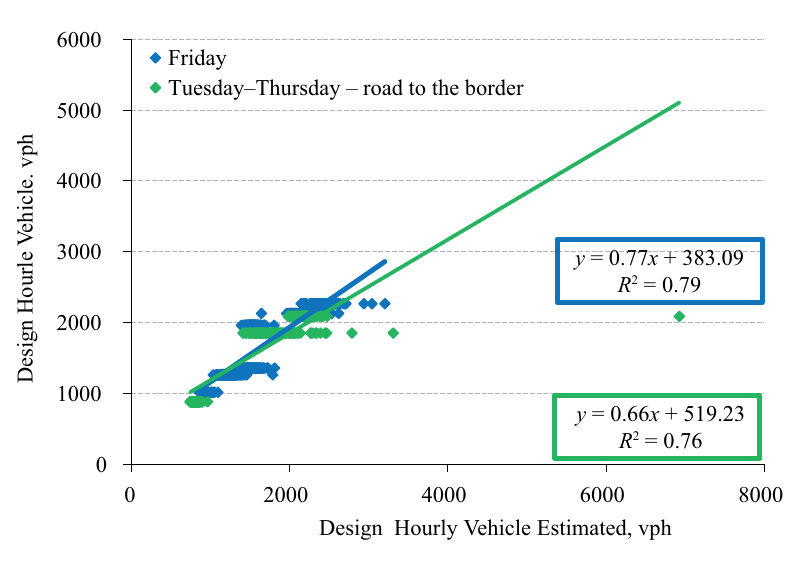
Figure 3. Graph of the relationship between the actual and